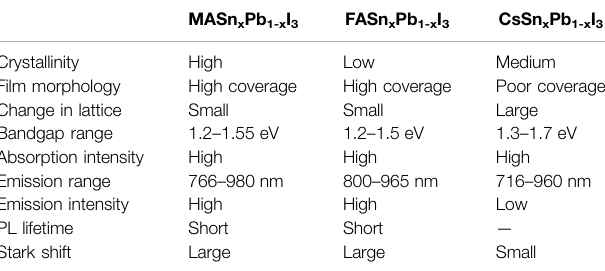
TABLE 1 | Summary of the material and spectral properties of the mixed Sn-Pb halide